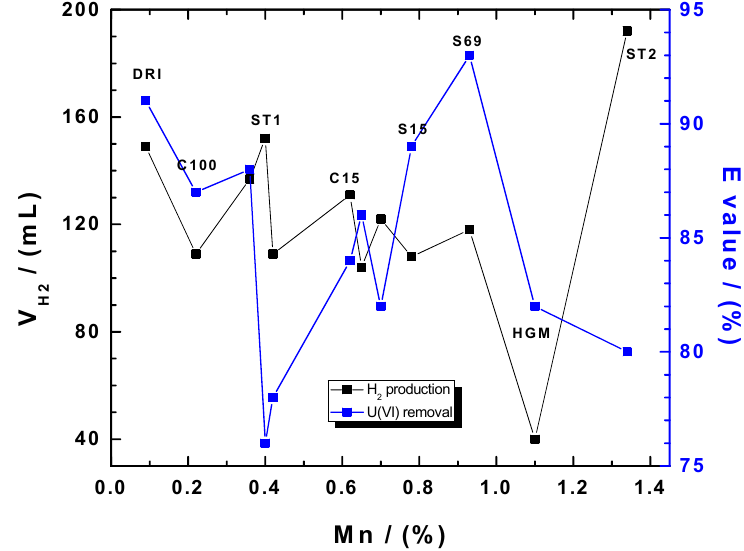
Figure 4. Changes of the volume of produced molecular hydrogen (H 2 ) and the percent U(VI) removal as a function of the manganese content (% Mn). The codes of selected Fe 0 specimens are indicated. The represented lines are not fitting functions, but they just connect points to ease visualization. Table 5. Summary of the existing Fe 0 materials reactivity characterization methods validated via comparison of results with that of contaminant removal. “CAHs” stand for “chlorinated aliphatic hydrocarbons” and “PCP” for “Pentachlorophenol”.